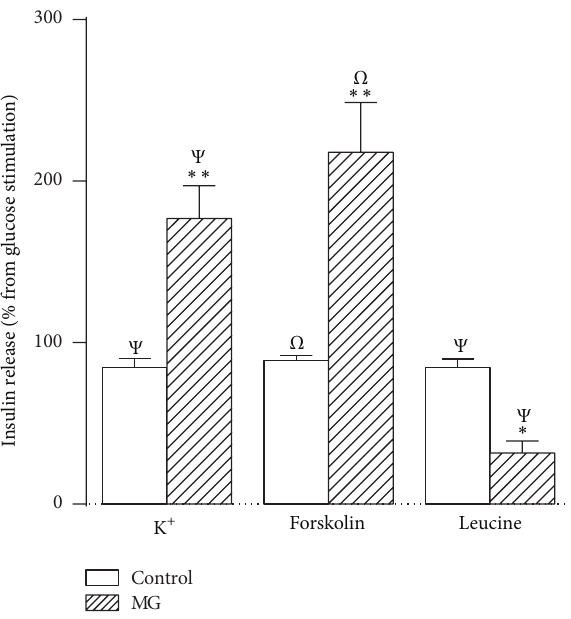
Figure 3: Effect of K + , forskolin, or leucine on GSIS. Insulin secretion was stimulated or inhibited by K + , forskolin, or leucine, as indicated below the 𝑥 -axis, in absence or presence of methylglyoxal. Bars represent the mean ± S.E.M. of the percentage of insulin release compared with their respective glucose concentrations, which are represented by the line from 0. K + , 40 mM of potassium + 5.6 mM of glucose; forskolin, 10 𝜇 M of forskolin + 8.3 mM of glucose; leucine, 10mM of leucine + 5.6 mM of glucose. Ψ 𝑃 < 0.001 compared with 5.6 mM of glucose; Ω 𝑃 < 0.001 compared with 8.3 mM of glucose; # 𝑃 < 0.001 compared with 16.7 mM of glucose; ∗ 𝑃 < 0.05 and ∗∗ 𝑃 < 0.001 compared with the respective control